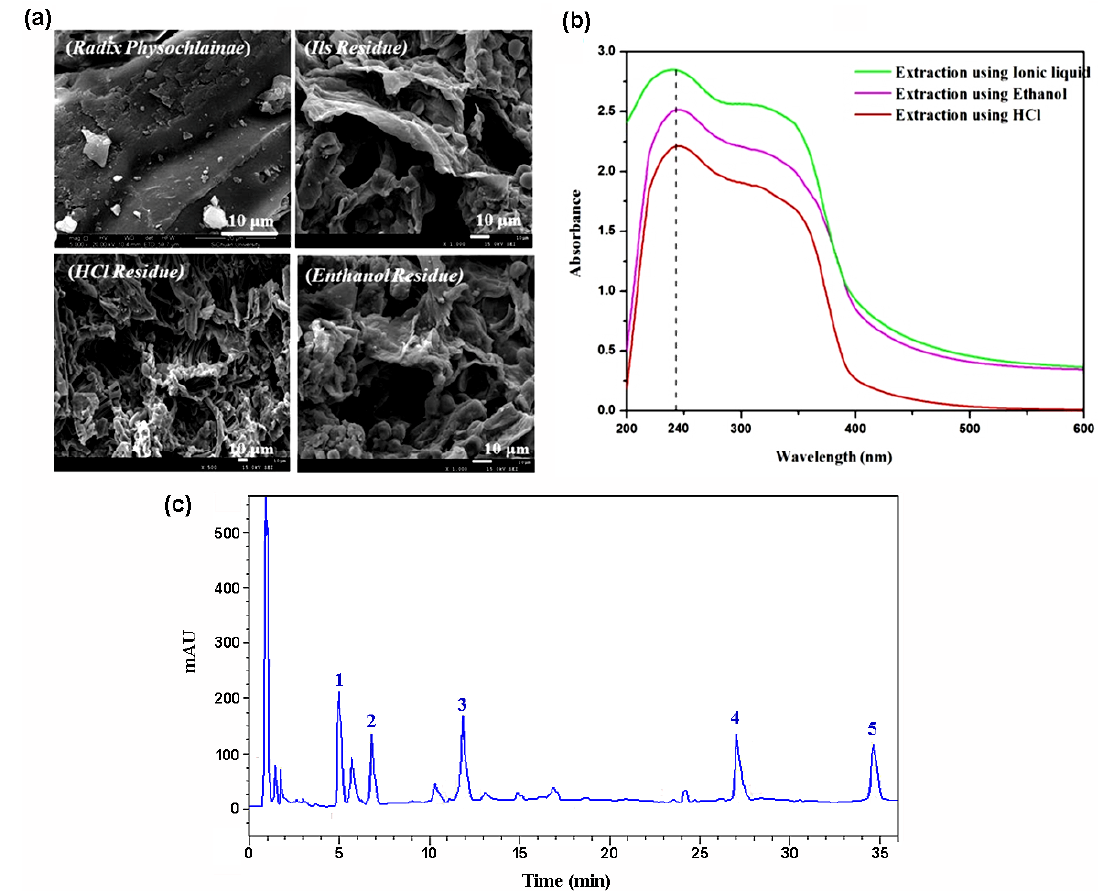
Figure 5. Comparison on SEM photos of herbal residue before and after extraction by different solvents ( a ), UV spectra for different extracts by various solvents ( b ) and chromatogram for five main alkaloids after extraction by IL ( c , 1: anisodamine, 2: atropine, 3: scopolamine, 4: aposcopolamine, 5: scopoline).